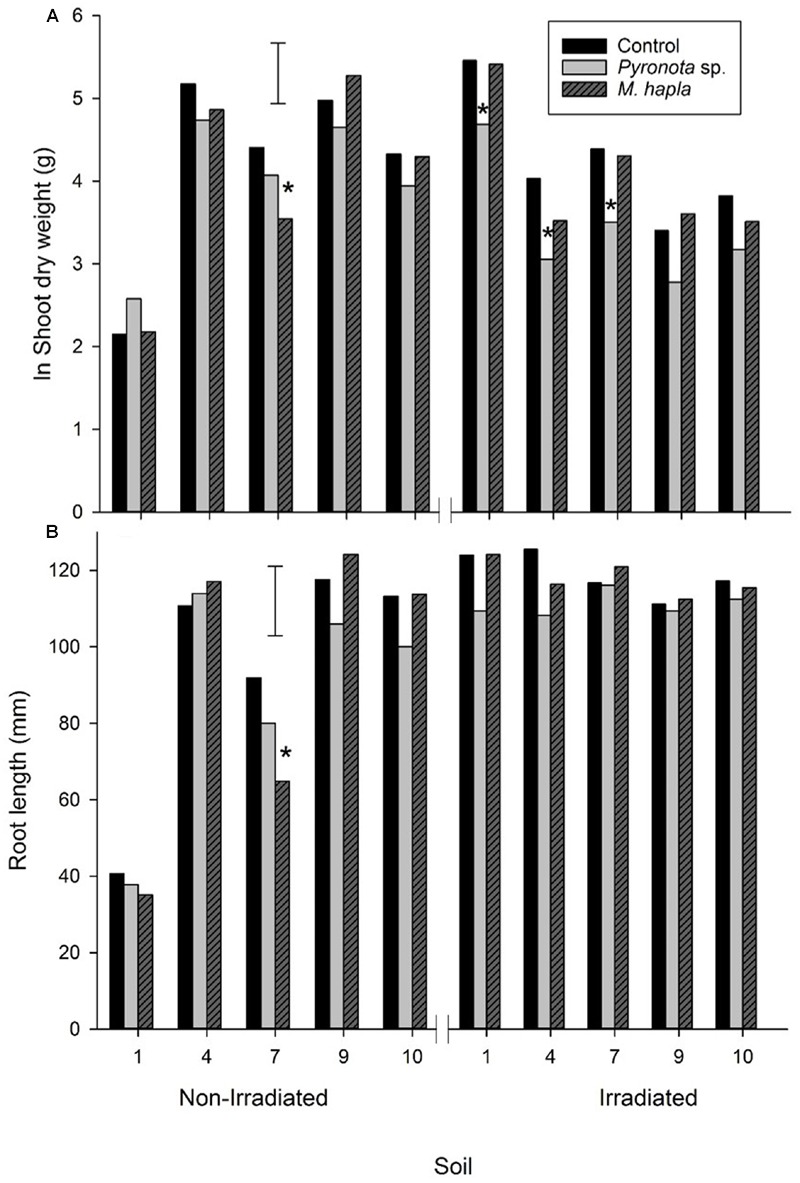
Experiment 2: Growth of white clover shoots (A) and roots (B), without invertebrate pests (control) or inoculated with C. zealandica or M. hapla, either before or after soil irradiation. Error bars are lsd 5%. Soils arranged as for Figure 3. Astrices denote significant difference to control within each soil.